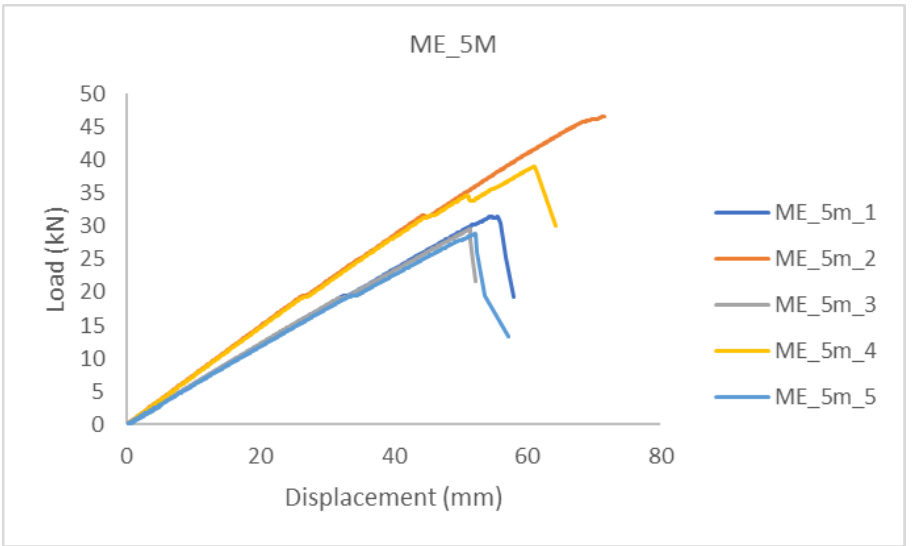
Figure 7. Load-displacement—hollow glued laminated samples.